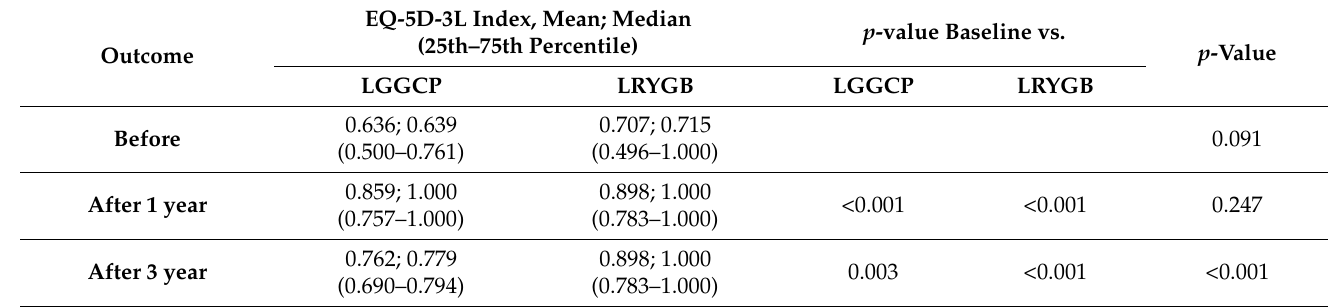
Table 7. Mean EQ-5D-3L index values before and after